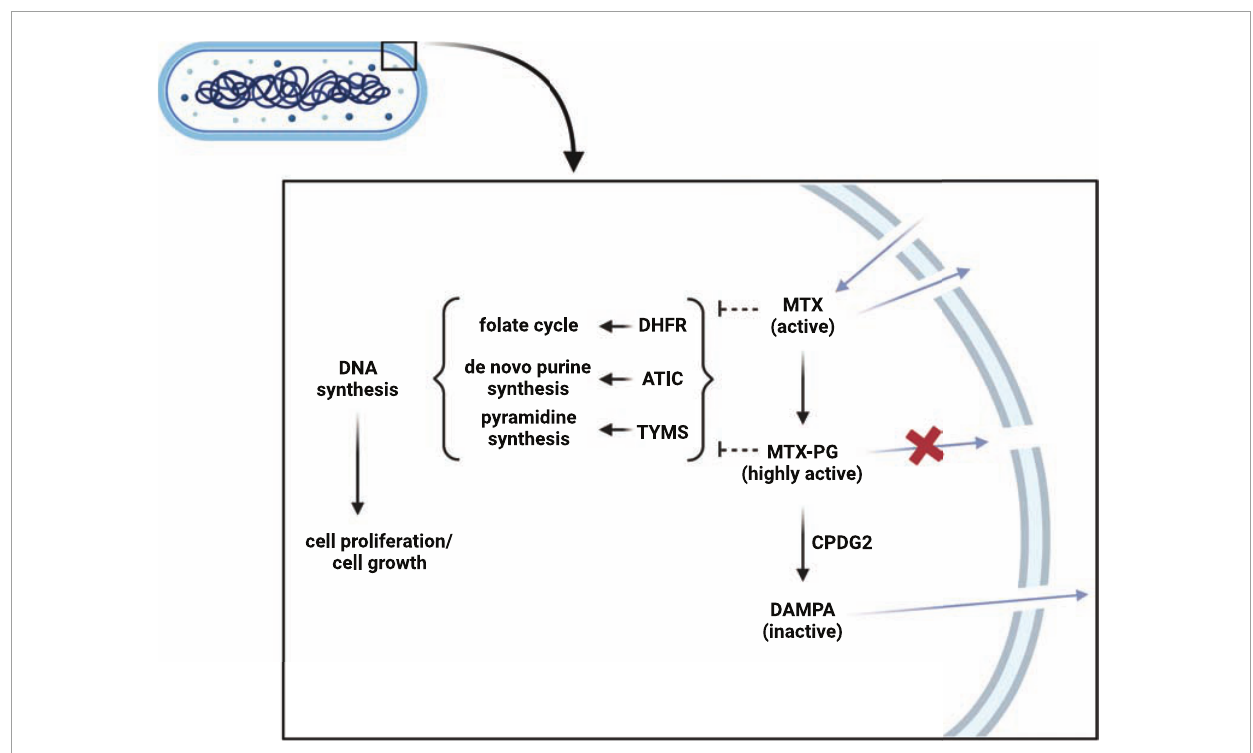
FIGURE3 Bacterial methotrexate (MTX) metabolism and interaction. MTX can enter the bacterial cell and can be polyglutamated into highly active MTX-PG. CPDG2-like enzymes can in turn inactivate MTX-PG into DAMPA. In contrast to MTX-PG, MTX and DAMPA can leave the bacterial cell. MTX and MTX-PG can interfere with DHFR, ATIC, and TYMS to subsequently inhibit DNA synthesis and bacterial growth. PG, polyglutamate; CPDG2, carboxypeptidase glutamate 2; DAMPA, 2,4-diamino-N-10-methylpteroic acid; DHFR, dihydrofolate reductase; ATIC, 5-aminoimidazole-4-carboxamide ribonucleotide formyltransferase/Inosine monophosphate cyclohydrolase; TYMS, thymidylate synthetase. Created with